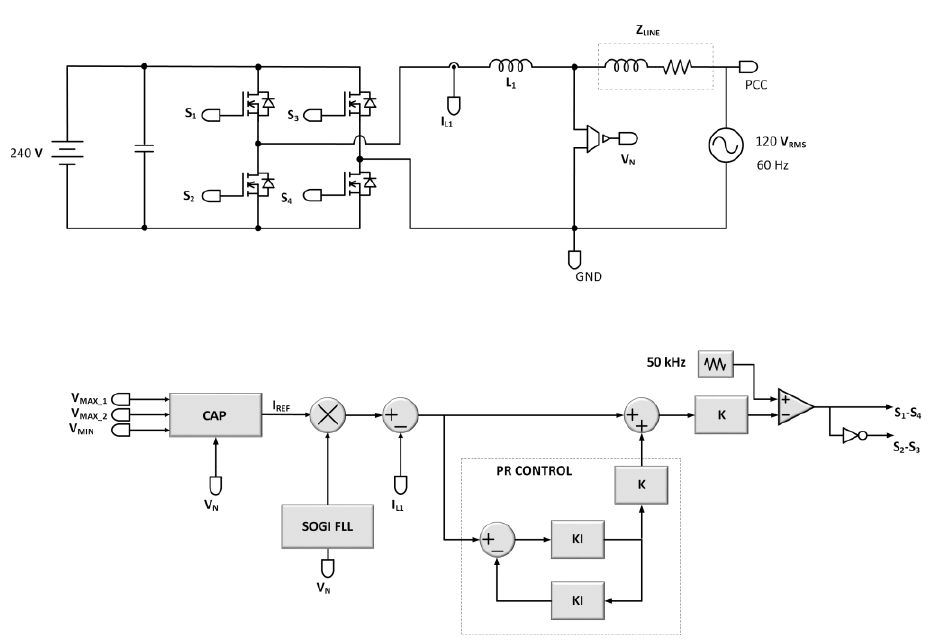
Figure 6. Currents demanded (A RMS ) by ESS under different regulating voltage levels.